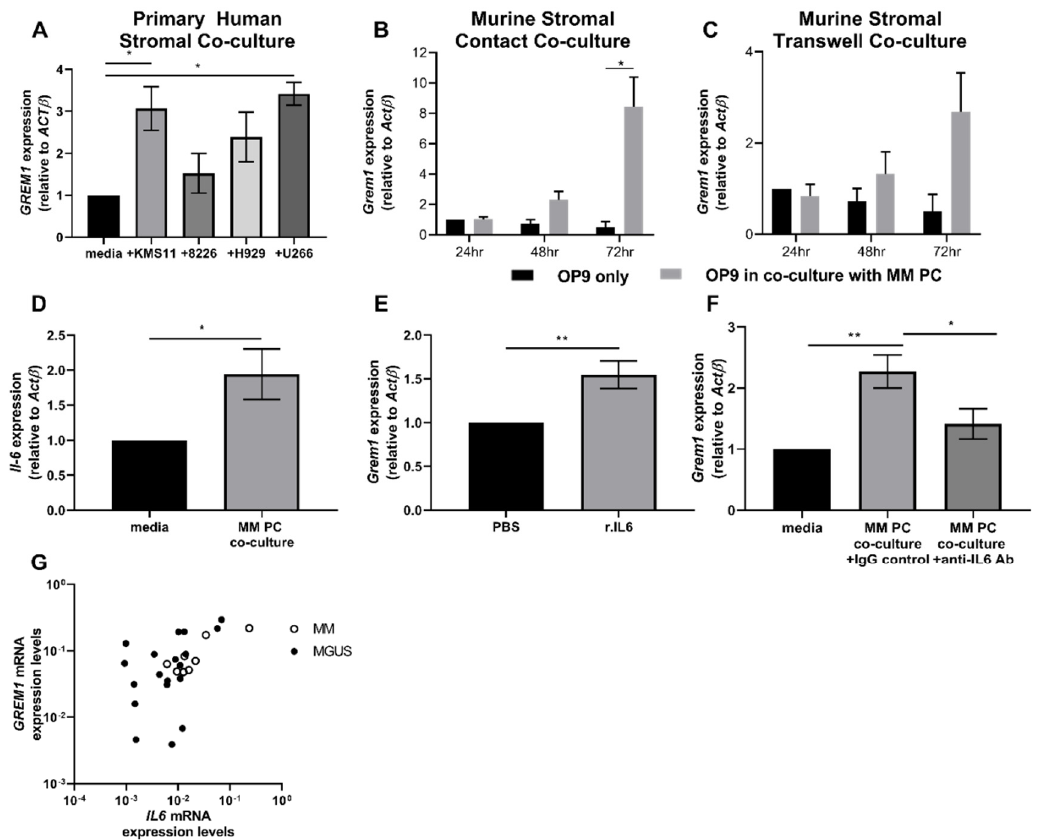
Figure 2. MM plasma cells (PCs) upregulate stromal expression of Grem1 in adherent co-culture via interleukin-6 (Il-6). RNA was extracted from ( A ) washed primary, normal human stroma previously co-cultured with KMS-11, RPMI-8226, H929, and U266 human MM cell lines for 72 h and ( B ) fluorescent-activated cell sorting (FACS) sorted green-fluorescent protein (GFP) + murine, bone-marrow-derived stromal OP9 cell lines previously co-cultured with 5TGM1 MM PCs in cell-contact and ( C ) Transwell culture conditions for 24, 48, and 72 h. GREM1 / Grem1 expression from stromal samples was analyzed by qPCR. ( D ) Il-6 expression was analyzed in the murine, BM-derived, stromal OP9 cell lines following 72 h culture in the absence / presence of 5TGM1 MM PCs. ( E ) OP9 stromal cells were cultured in the absence / presence of 20 ng / mL murine recombinant Il-6 (r.Il-6) for 72 h and analyzed for Grem1 expression. ( F ) OP9 stromal cells were cultured in either media only or in co-culture with 5TGM1 MM PCs in presence of 0.05 µ g / mL anti-Il-6 neutralizing antibody (MM PC co-culture + anti-Il-6 Ab) or immunoglobulin G (IgG) antibody control (MM PC co-culture + IgG control) and analyzed for Grem1 expression. Graphs depict data presented as mRNA expression normalized to β -Actin ( ACTB / ActB ), mean ± standard error of the mean of three replicate